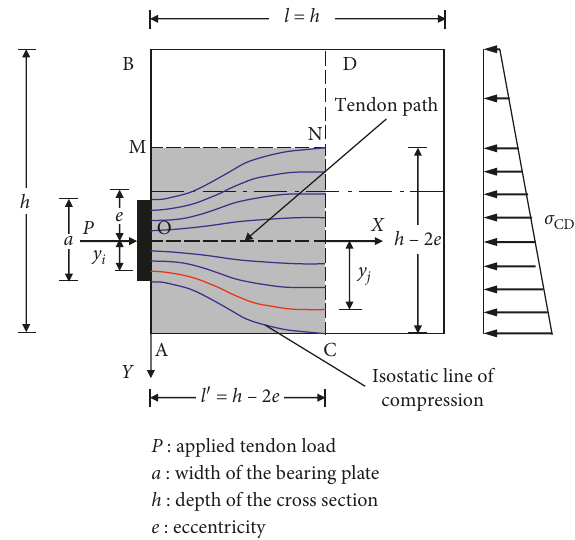
Figure 3: The symmetrical prism approach in the eccentric an- chorage zone (reproduced from Zhou et al. [5], under the Creative Commons Attribution license/public